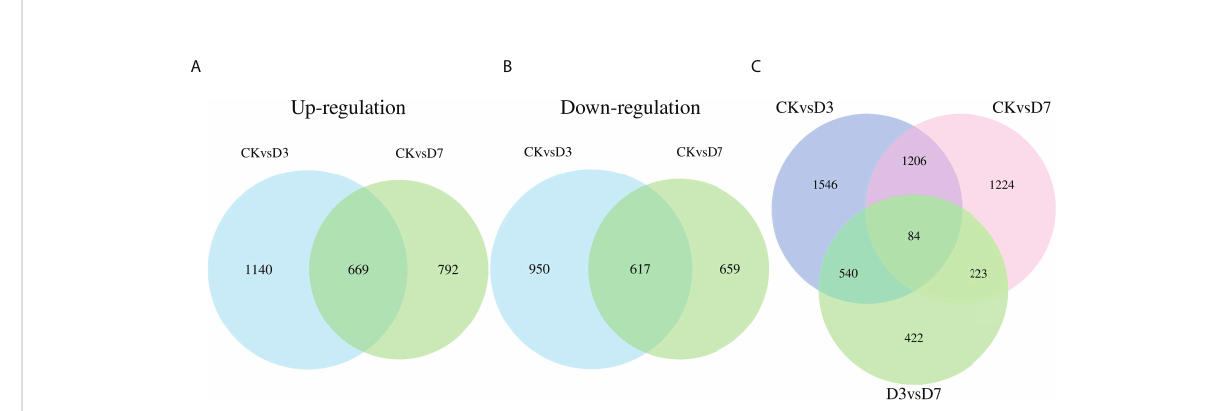
FIGURE 1 Venn diagrams of differentially expressed genes (DEGs) detected in the spleens of rainbow trout, following Flavobacterium psychrophilum and mock challenge infections. (A, B) Quantities of up- and downregulated DEGs between groups CK (contro l group) vs. D3 (day 3) and CK vs. D7 (day 7). (C) Quantities of DEGs among the three groups.